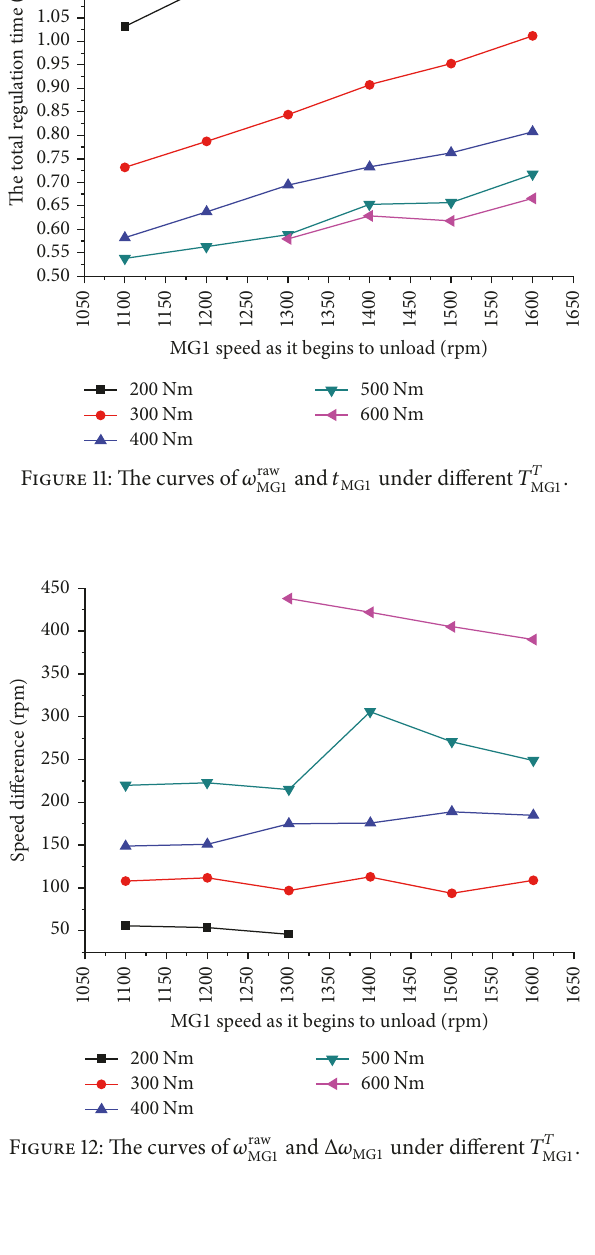
main target at the moment due to the fact that the speed regulation time is relatively small. 𝜔 raw MG 1 can be obtained from (33) after